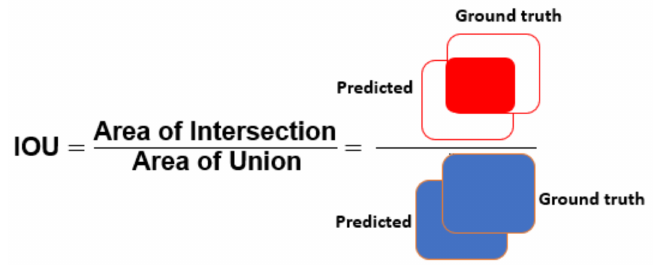
Figure 5. Pictorial representation of